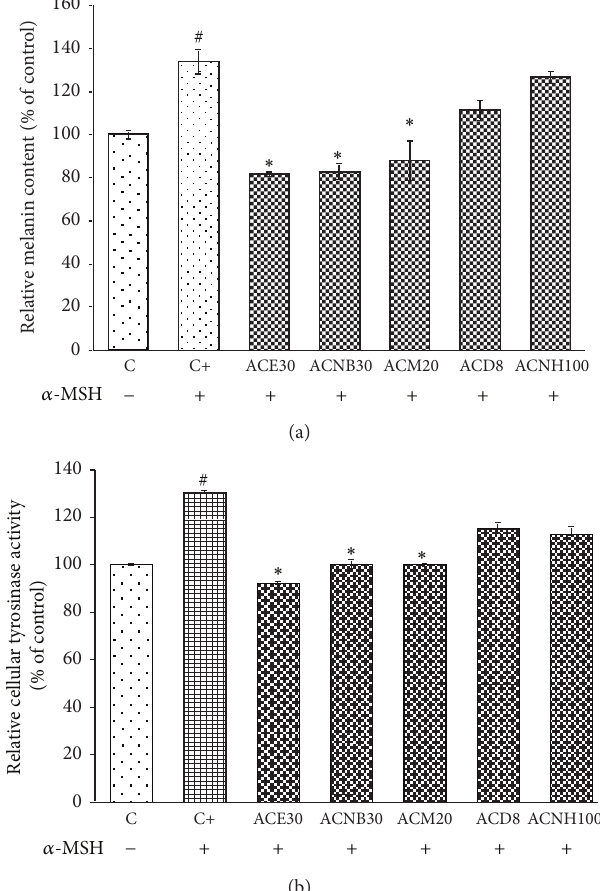
Figure 1: Total phenolic content of A. Communis methanol extract and its different partition extracts. Each percentage value was expressed as the means ± SD of three independent experiments. ∗ 𝑃 < 0.05 , significant difference with ACNH.